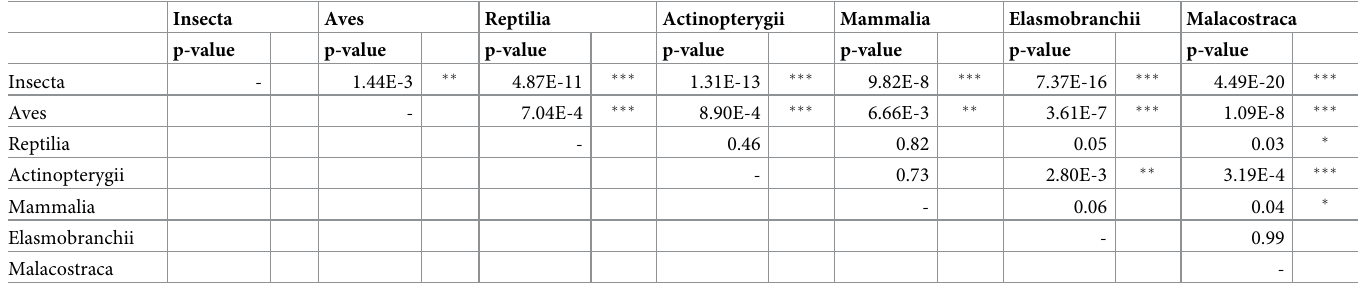
Table 1. Linear-mixed models (LMM) results testing for differences of Critical Fusion Frequencies (CFF) between the most studied taxonomic classes.